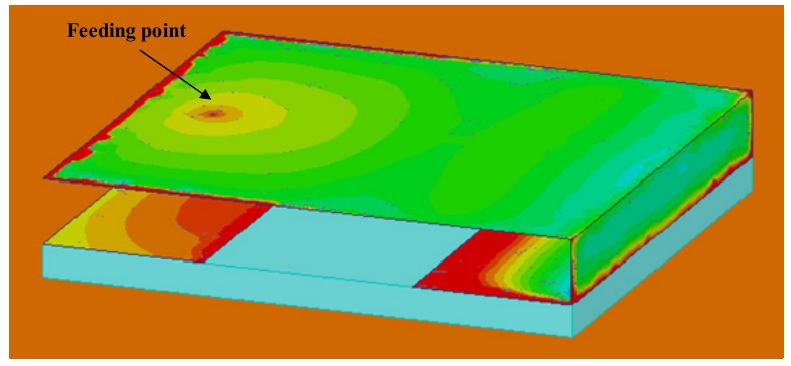
Figure 12. Simulated current distribution at 2.45 GHz.